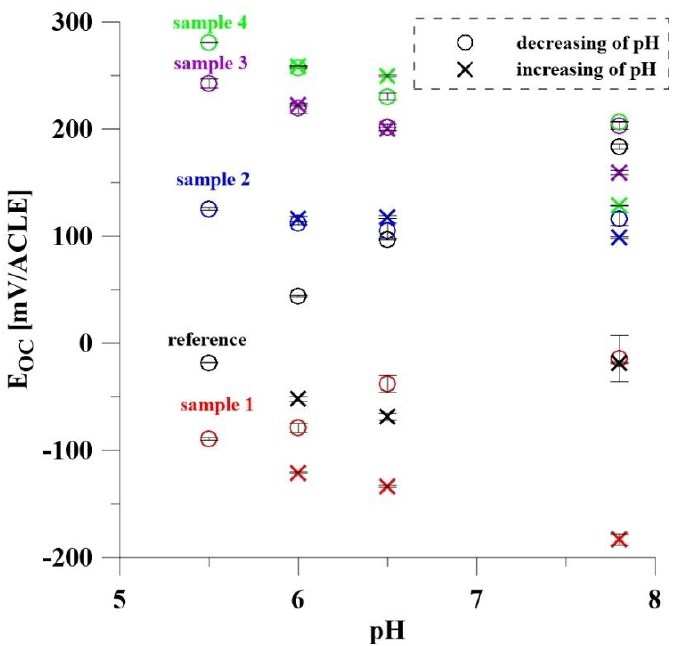
Figure 5. Calculated average E OC values of all samples as a function of pH.